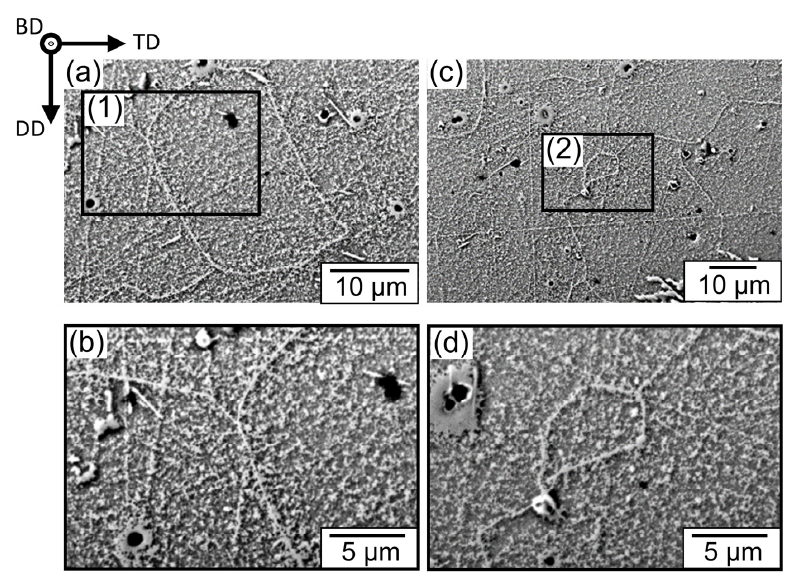
Figure 6. SEM image of the polished and etched DD-TD section; ( a ) showing an overview of a subgrain (approx. 32 µm diameter) inside a large α grain and in ( b ) magnification of area ( 1 ) showing the triple junction grain boundary of the subgrain; ( c ) shows the grain interior of another large α grain with a small subgrain (7–9 µm diameter) and in ( d ) the subgrain from area ( 2 ) is shown; the sample coordinate system is defined by the building direction (BD), deposition direction (DD) and transverse direction (TD).